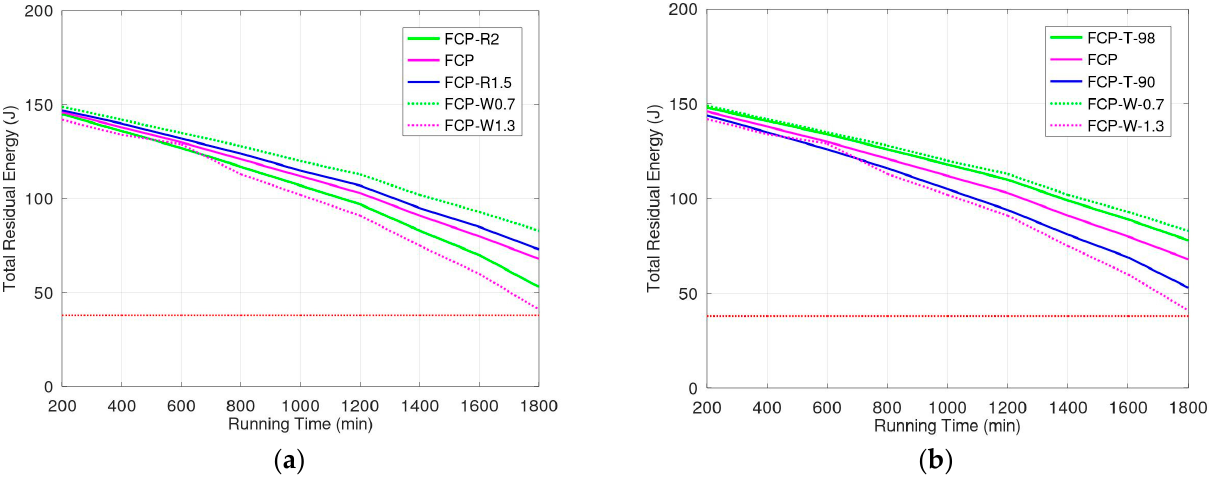
Figure 11. ( a ) Energy consumption of cells of di ff erent sizes and sensors of di ff erent weights; ( b ) Energy consumption from energy transmission among sensors.